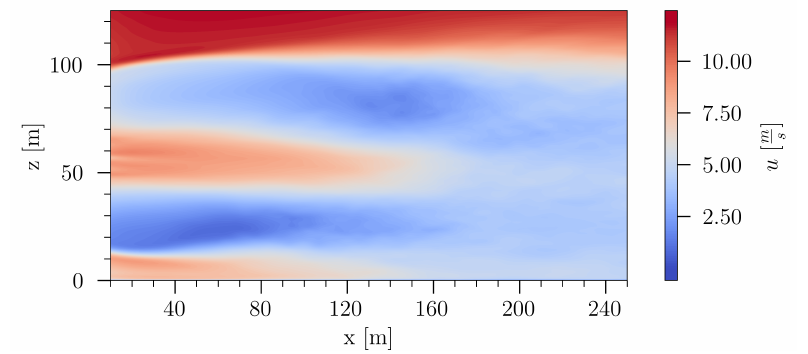
Figure 21. Time averaged mean velocity field in the wake of the wind turbine